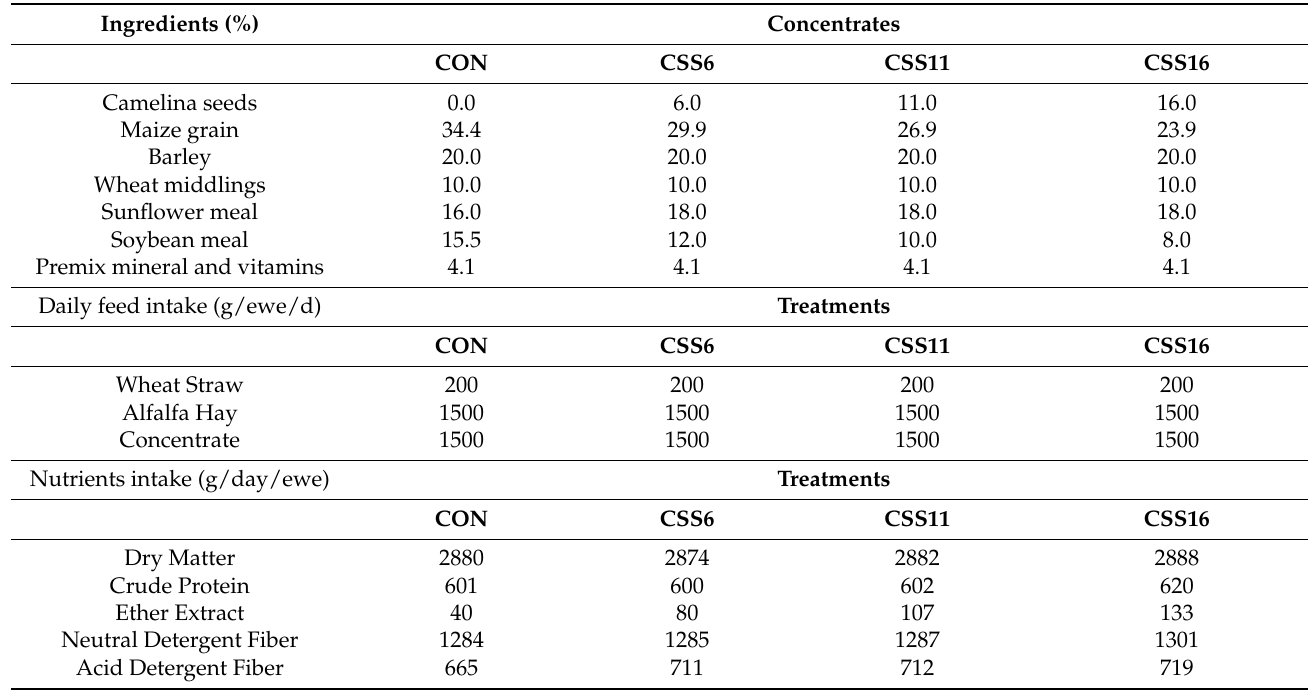
Table 1. Concentrates composition (g/kg), diet intake (g), daily nutrients intake (g/ewe), and feeds chemical composition and fatty acid profile